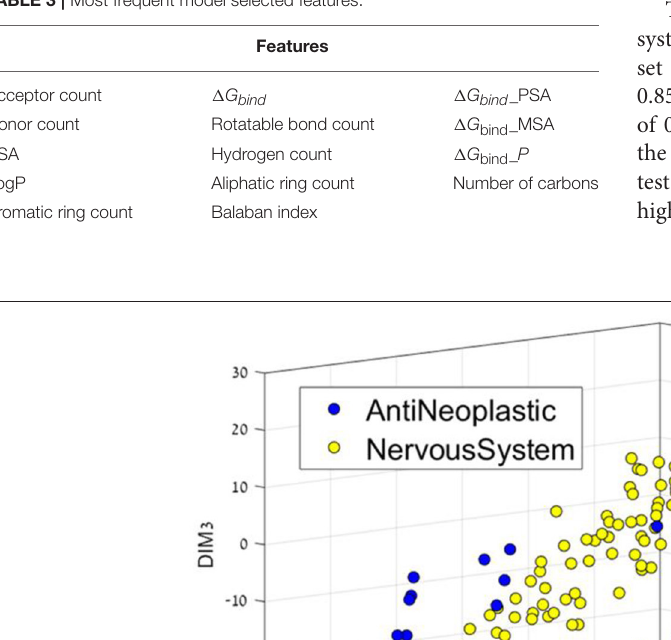
Frontiers in Chemistry |